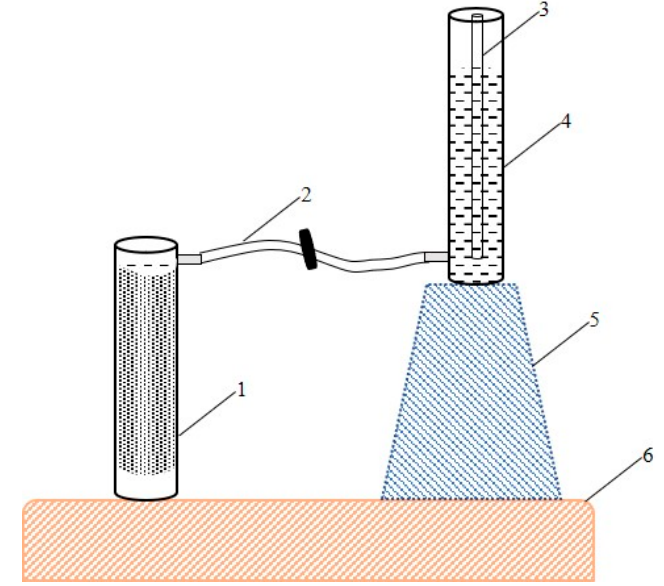
Figure 1. Experimental setup for one-dimension vertical water infiltration. (1) Soil column; (2) Water pipe; (3) Intake tube; (4) Markov bottle; (5) Retort stand; and (6) Desktop.